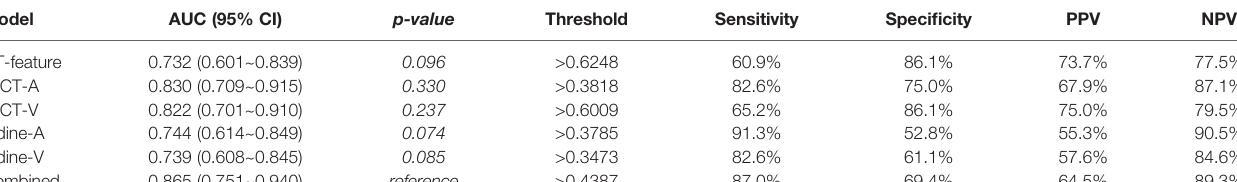
TABLE 3 | Performance comparison of different models in the independent testing set. Model